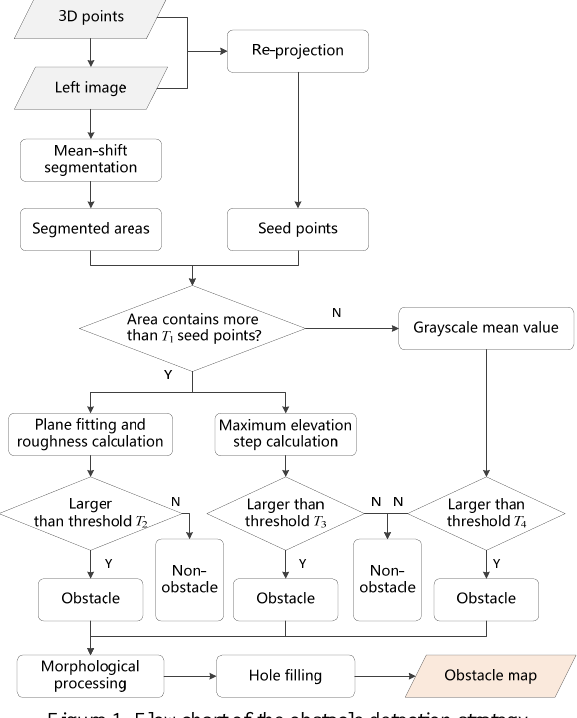
Figure 1. Flowchart of the obstacle detection strategy combining 2D and 3D